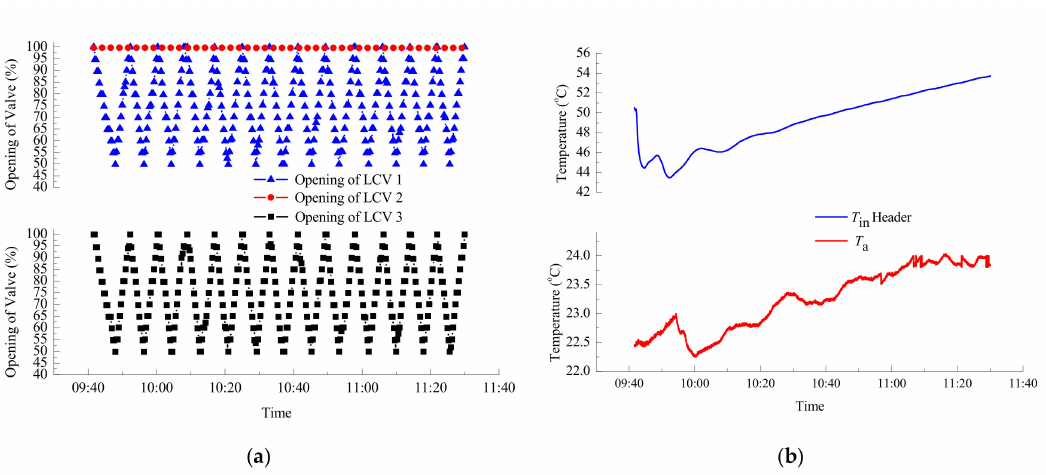
Figure 8. Measured initial data in the cod test: ( a ) opening of three LCVs; ( b ) ambient and header inlet